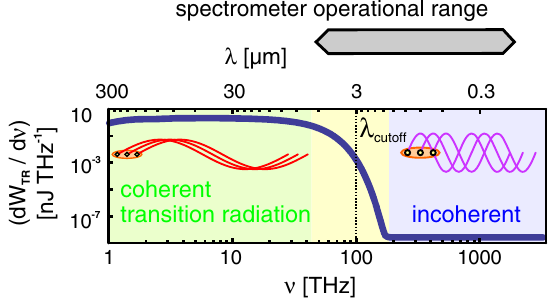
FIG. 1. Simulated spectral intensity of TR emitted by an unstructured, Gaussian-distributed electron bunch with 20 pC charge, 200 MeV energy and 10 fs (FWHM) duration, as predicted by semianalytically integrating TR contributions over the 6D electron phase space according to Ref. [28]. Coherent transition radiation (CTR) is generated when the emitted wave- lengths are longer than the bunch length, while incoherent transition radiation (ITR) dominates for shorter wavelengths. The operational range of the spectrometer is indicated, covering 250 nm to 11 . 35 μ